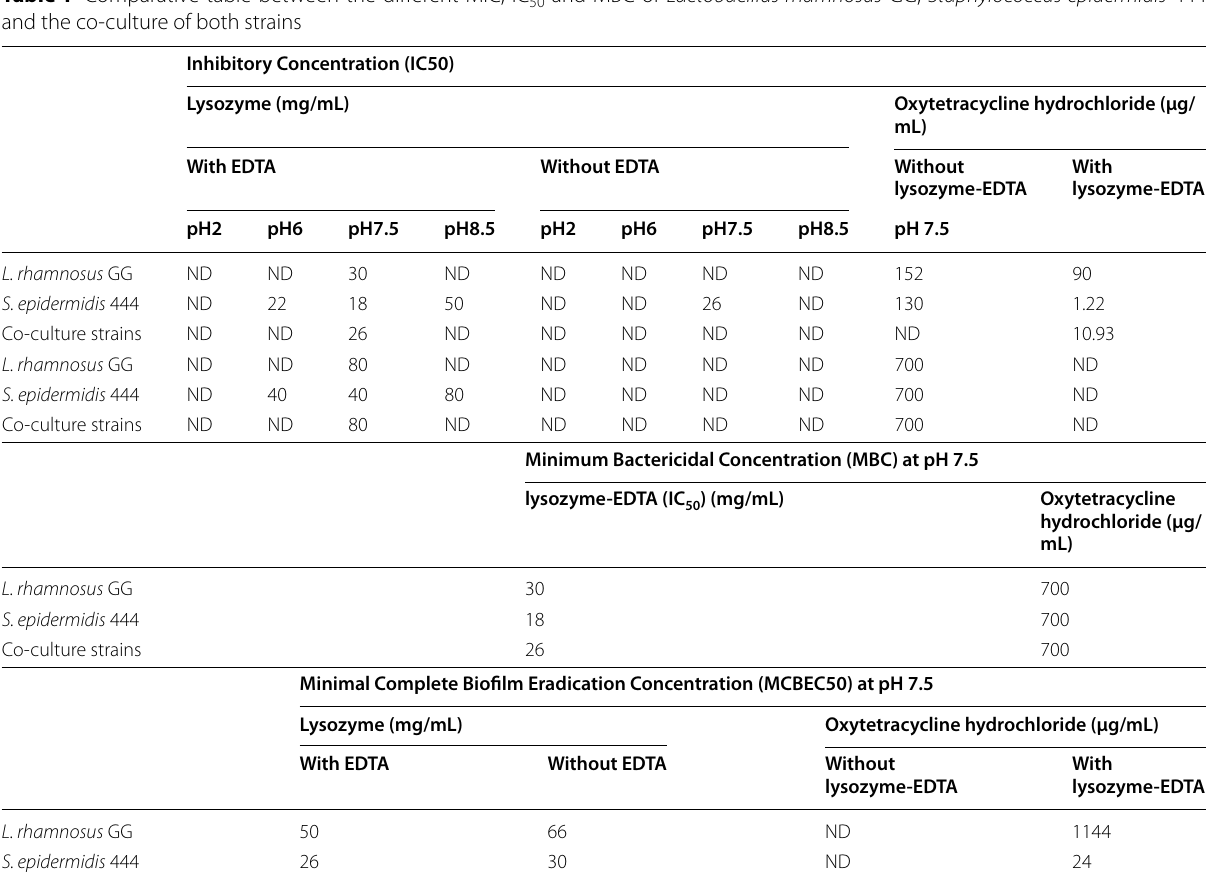
and MBC of Lactobacillus rhamnosus GG, Staphylococcus epidermidis 444 50